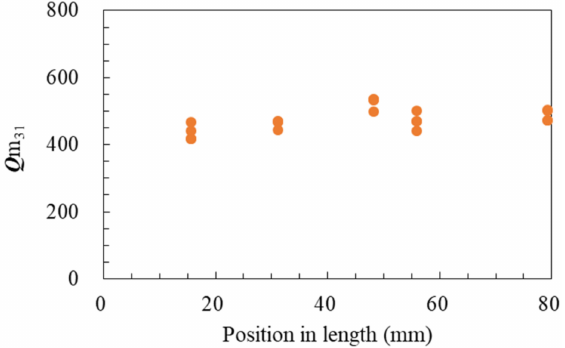
Figure 7. Distributions of Q m 31 along the growth direction for the Mn:PIN-PMN-PT boule.